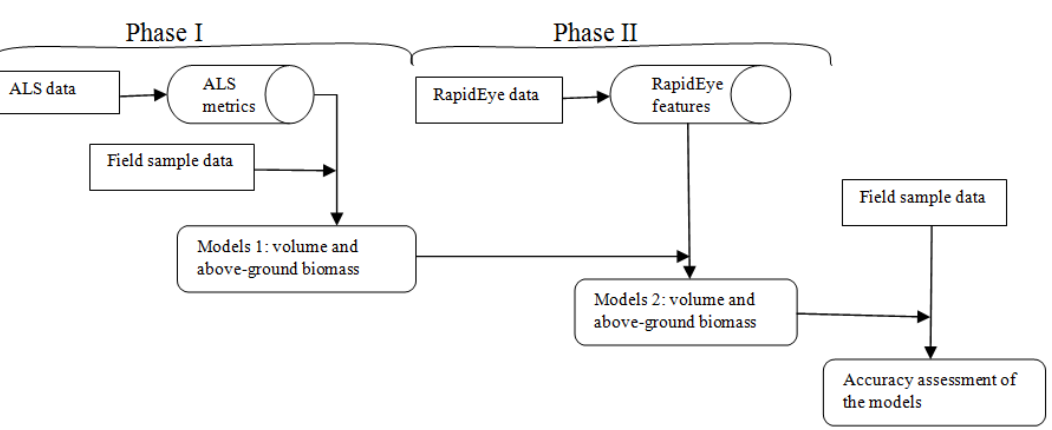
Figure 4. Flowchart of the two-phase sampling